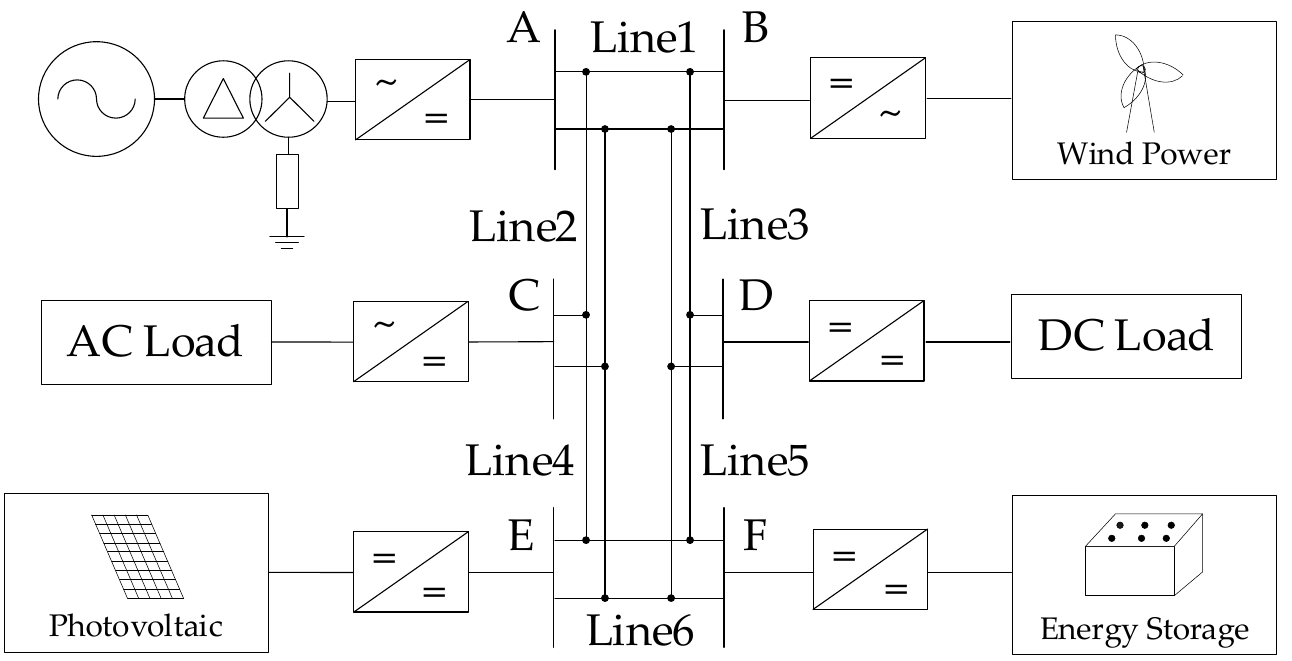
Figure 1. Topology of a six-terminal DC distribution network.